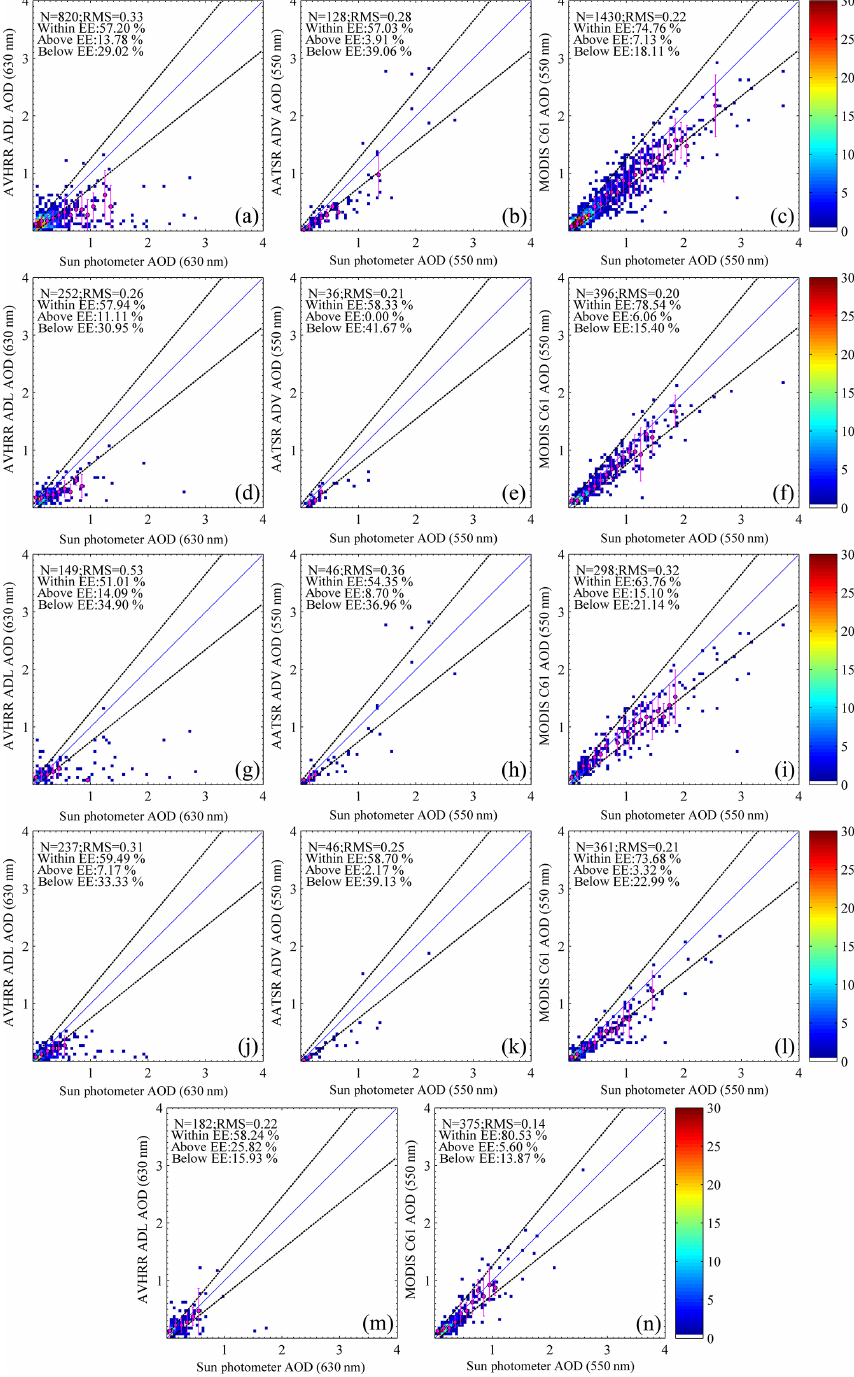
Figure A2. Scatter density plots of satellite-retrieved AOD vs. sun-photometer-retrieved AOD data from Beijing station. The ADL of all data (a) , only spring data (d) , only summer data (g) , only autumn data (j) and only winter data (m) vs. AERONET. The ADV of all data (b) , only spring data (e) , only summer data (h) and only autumn data (k) vs. AERONET. MODIS using all data (c) , only spring data (f) , only summer data (i) , only autumn data (l) and only winter data (n) vs.